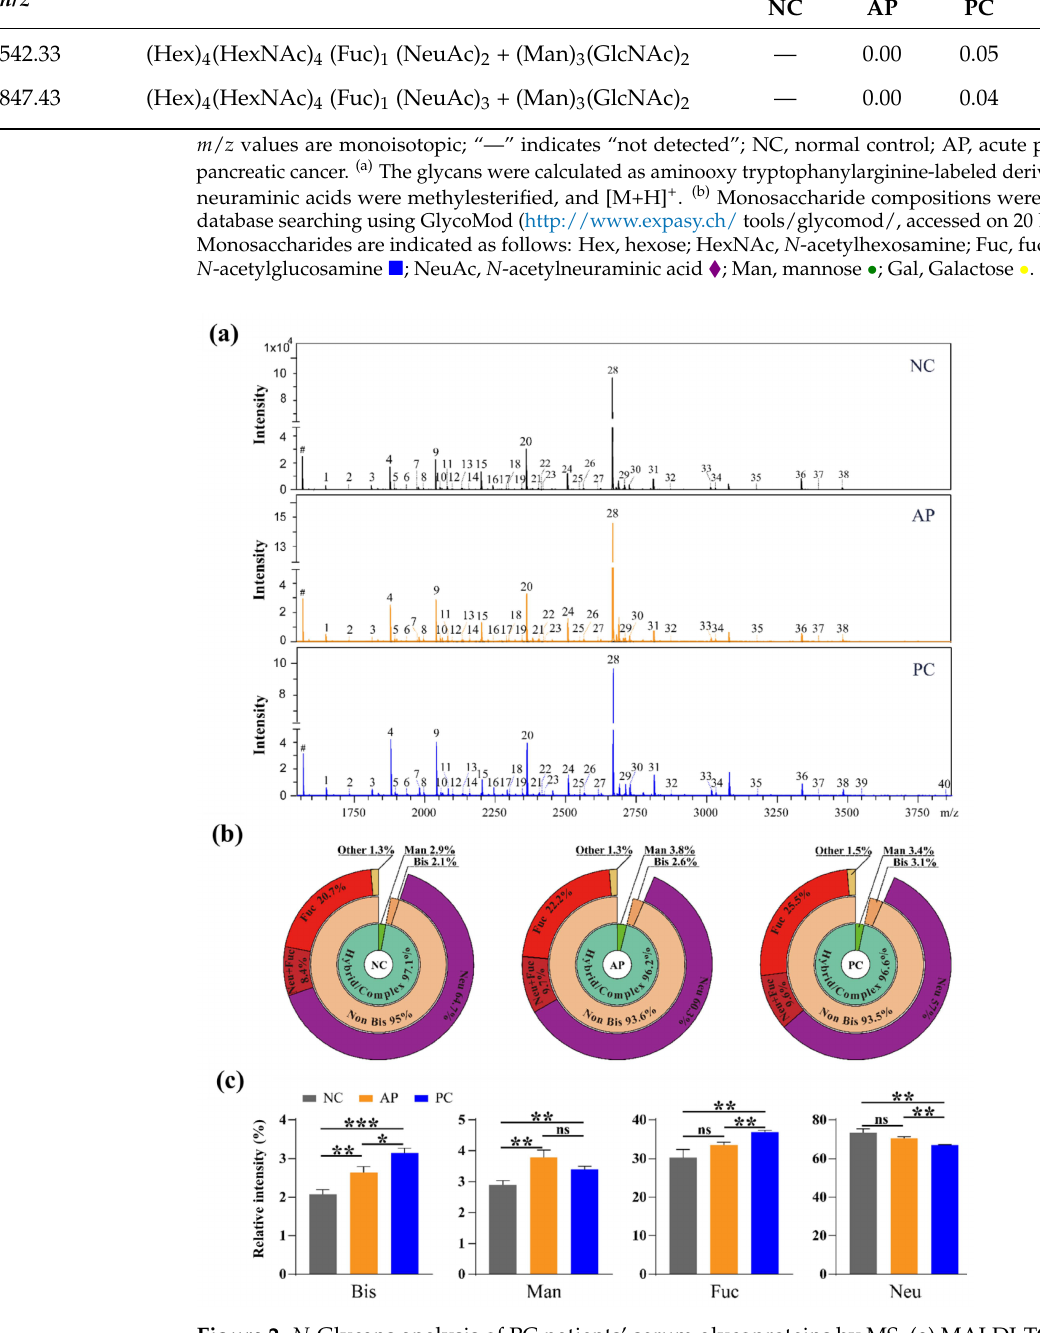
Figure 2. N -Glycans analysis of PC patients’ serum glycoproteins by MS. ( a ) MALDI-TOF MS spectra of N -glycans of pooled human sera derived from NC (top, n = 8), AP (middle, n = 8), and PC (bottom, n = 8). ( b ) Sunburst charts showing the relative abundances of all the N -glycan types in different groups. ( c ) Relative intensities of bisected, mannosylated, fucosylated, and sialylated N -glycans were statistically analyzed. The relative intensity of each glycan was calculated by normalizing the intensity of an individual glycan with the intensity of internal standard glycan. # indicates the internal standard glycan. Glycan peaks are numbered and summarized in Table 1. All values are means ± SD (error bars). NC, normal control; AP, acute pancreatitis; PC, pancreatic cancer; *, significantly different p < 0.05; **, p < 0.01; ***, p < 0.001; ns, no significant